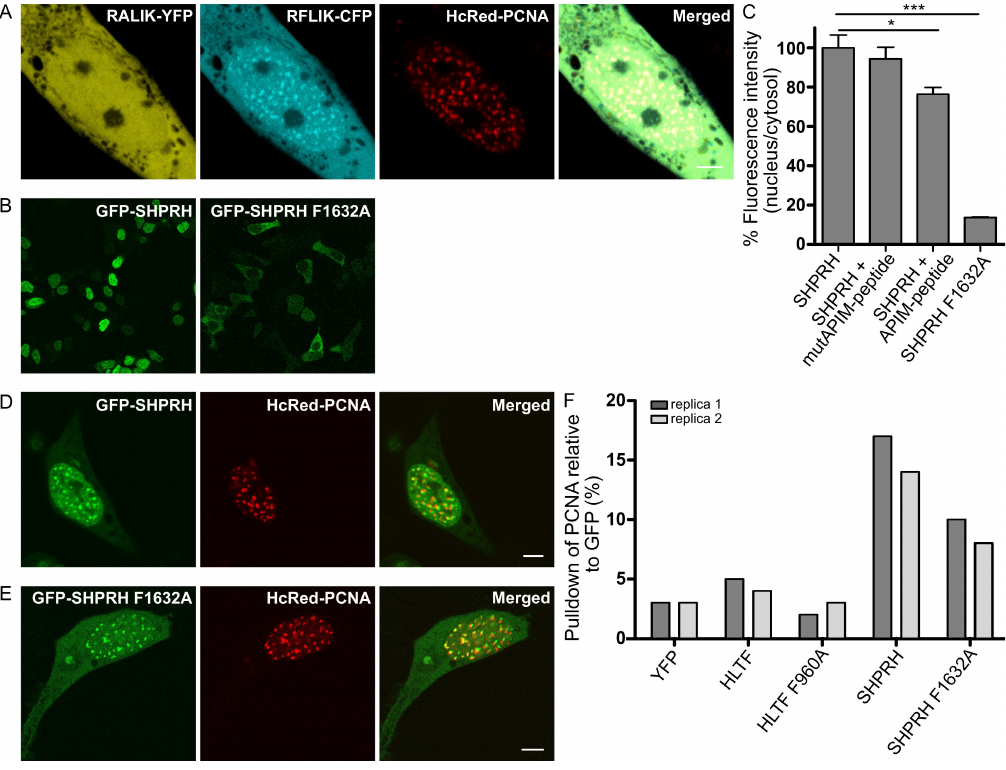
Figure 2. SHPRH localization in the nucleus is dependent on APIM. ( A ) Overexpressed RALIK-YFP (mutAPIM in SHPRH), RFLIK-CFP (APIM in SHPRH), and HcRed-PCNA. ( B ) Overview of subcellular localization of GFP-SHPRH and GFP-SHPRH F1632A, and ( C ) Quantification of nuclear localization of GFP-SHPRH ( n (number of foci) = 484) and GFP-SHPRH F1632A ( n = 123), and GFP-SHPRH after treatment with an APIM peptide ( n = 247) or mutAPIM-peptide ( n = 319), average of three biological replica, normalized to untreated control, two-sided Student’s t -test, * p < 0.05, *** p < 0.001. ( D ) Overexpressed GFP-SHPRH and HcRed-PCNA and ( E ) GFP-SHPRH F1632A and HcRed-PCNA. All images are from live cells. Scale bar = 5 µ m. ( F ) Quantification of PCNA level pulled down by anti-GFP from YFP-HLTF, YFP-HLTF F960A, GFP-SHPRH, and GFP-SHPRH F1632A transfected cells after weak cross-linking and MMS treatment. Level of PCNA is given as % of total GFP-protein pulled down. Two independent biological replicas are